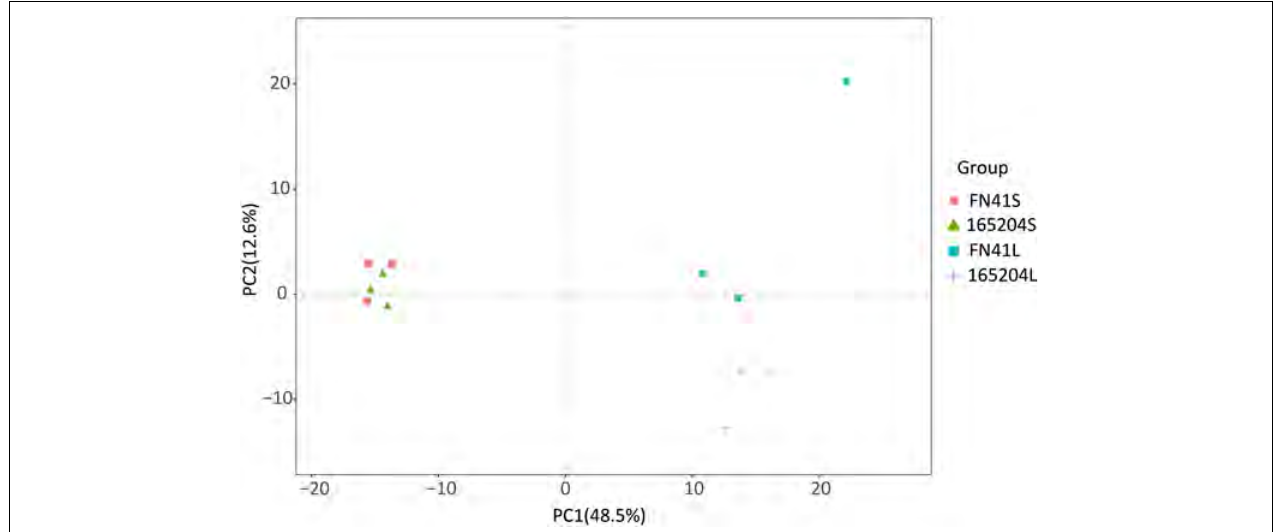
FIGURE 2 | Principal component analysis (PCA) of the metabolites detected in the sugarcane stem and leaf samples with three biological replicates. “FN41L” and “165204L” represent the leaf tissues of sugarcane varieties FN41 and 165204, respectively; “FN41S” and “165204S” represent the stem tissues of sugarcane varieties FN41 and 165204, respectively, similarly